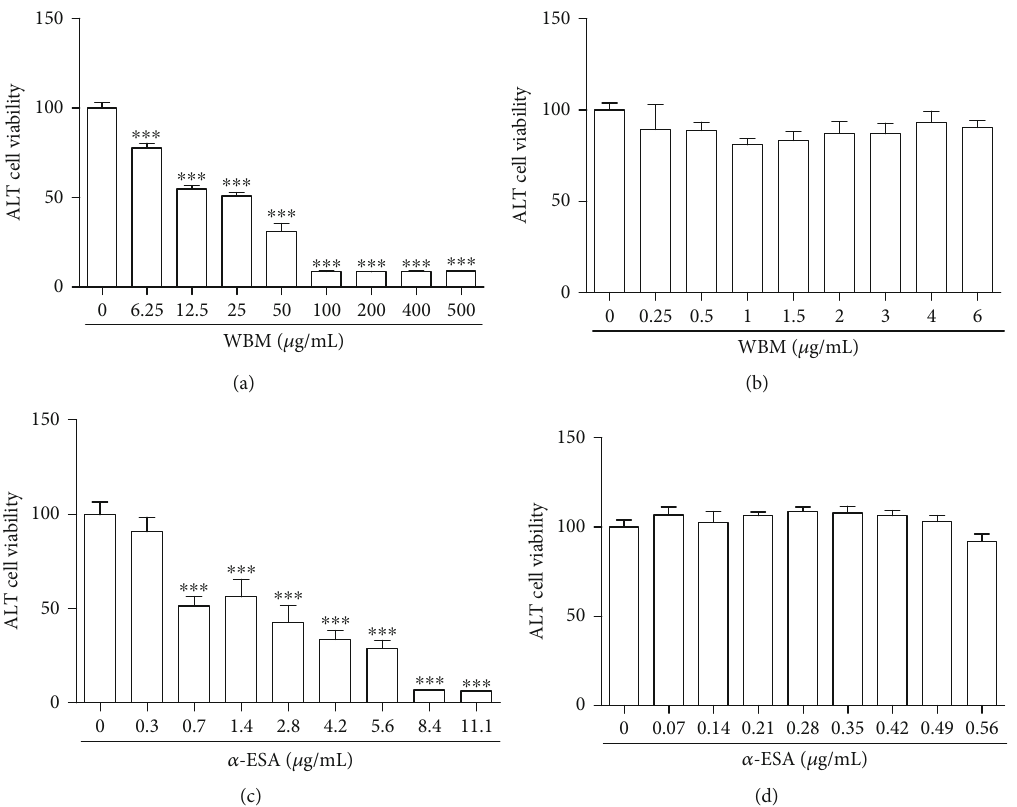
Figure 1: Cell survival, as measured by MTT assay, of ALT astrocytes following treatment with varying doses of WBM (0.25-500 μ g/mL) (a) and α -ESA (0.07-11.1 μ g/mL) (c). Concentrations with less cytotoxic e ff ects were determined ( > 80% of cell viability) at 0.25-6 μ g/mL in WBM (b) and 0.07-0.56 μ g/mL in α -ESA (d). For in vitro experiments, 1 μ g/mL WBM and 0.28 μ g/mL α -ESA were selected. Vertical bars indicate the mean ± standard errorof the mean (SEM) ( n = 3 ). ∗∗∗ P < 0 : 001 vs. control. Pair-wise multiple comparisons between groups were determined using the Newman-Keuls